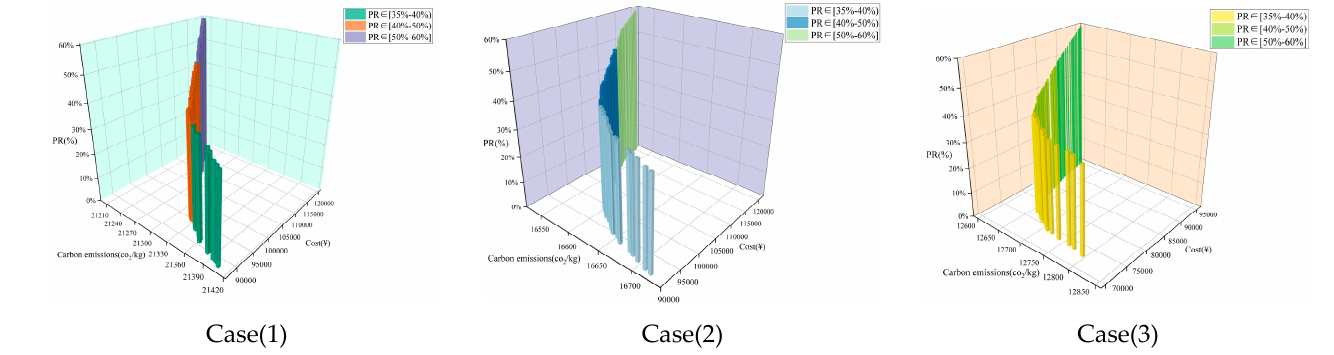
Figure 3. Pareto frontier diagram (Case(1) Case(2) Case(3)).